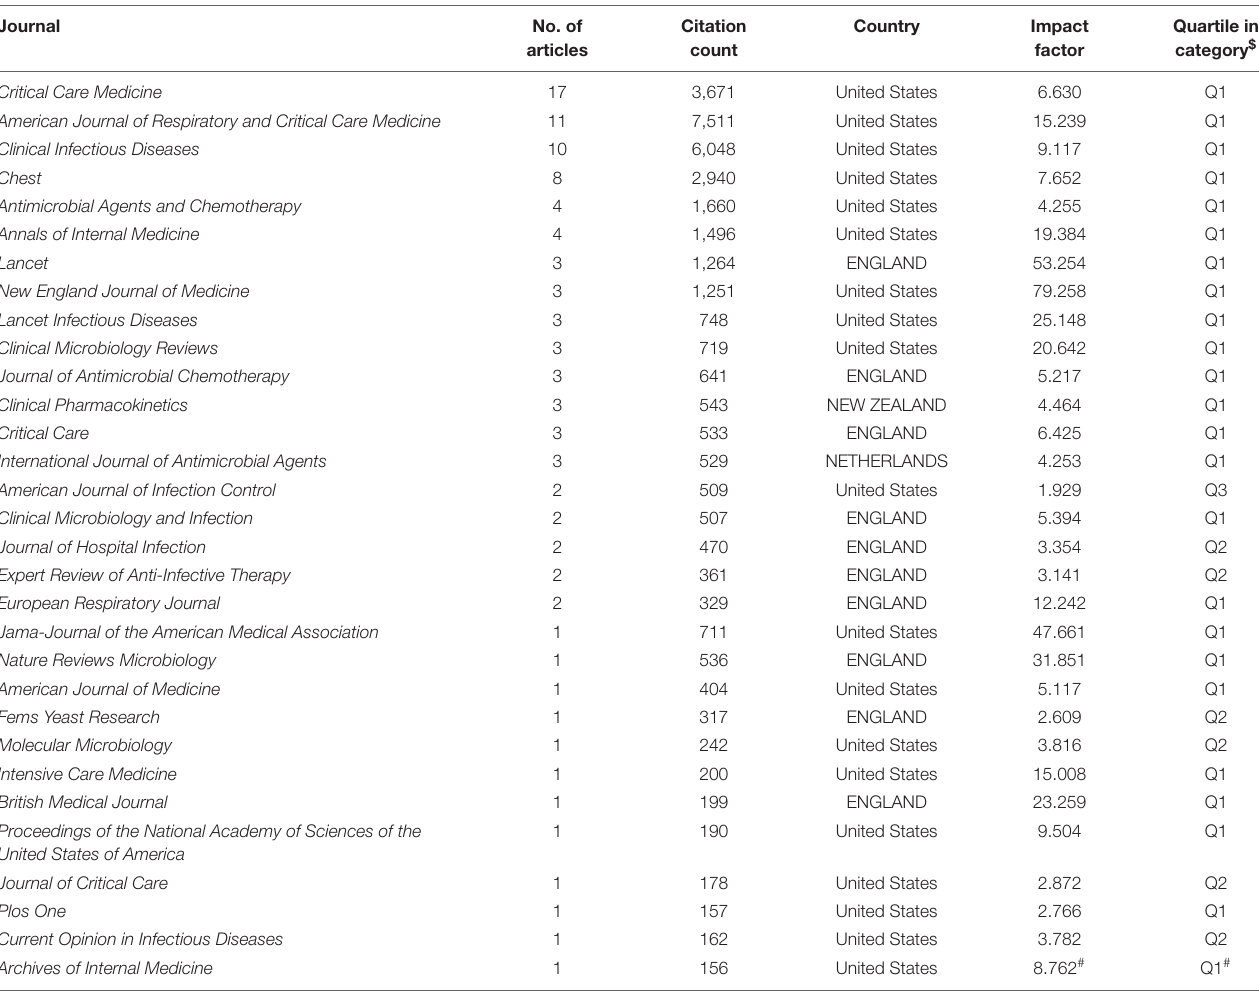
TABLE 3 | Journals of the 100 most-cited